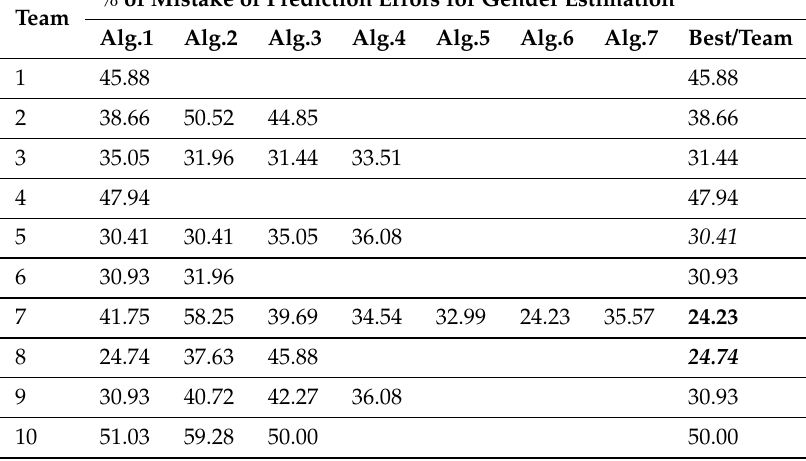
Table 6. Comparison of predicted errors for gender estimation. Note that 8 out of 10 teams submitted multiple results using different algorithms (Alg.). ‘Best/team’ is the Best result for each team is considered. 1st position is highlighted as bold ; 2nd best result is shown as bold-italic ; and 3rd best result is marked by italic .